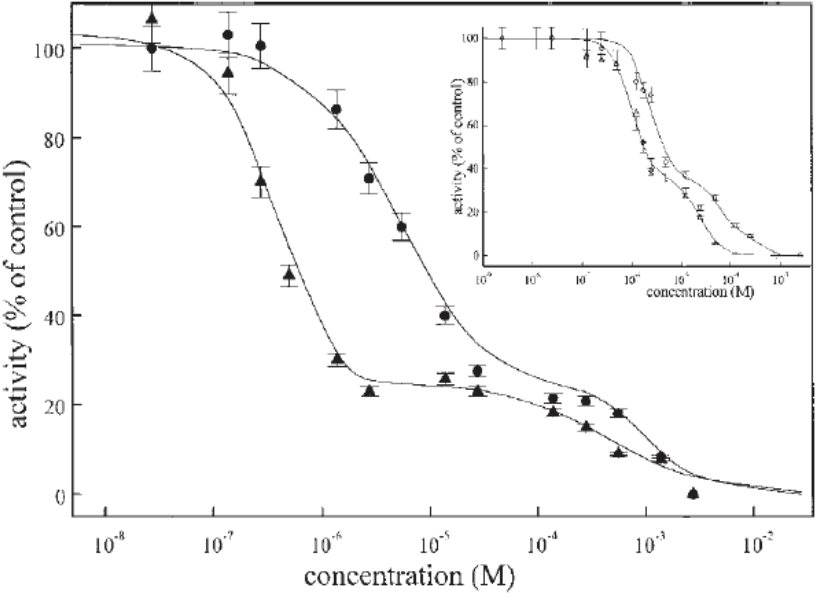
Figure 2. Inhibition of Na + ,K + -ATPase activity by digoxin (circles) and gitoxin (up triangles) in human erythrocyte membrane and commercial porcine cerebral cortex (inset). The solid lines represent the theoretical curves assuming two-site model fit, using values for high and low affinity isoenzymes. Reproduced experimentally determined IC 50 from